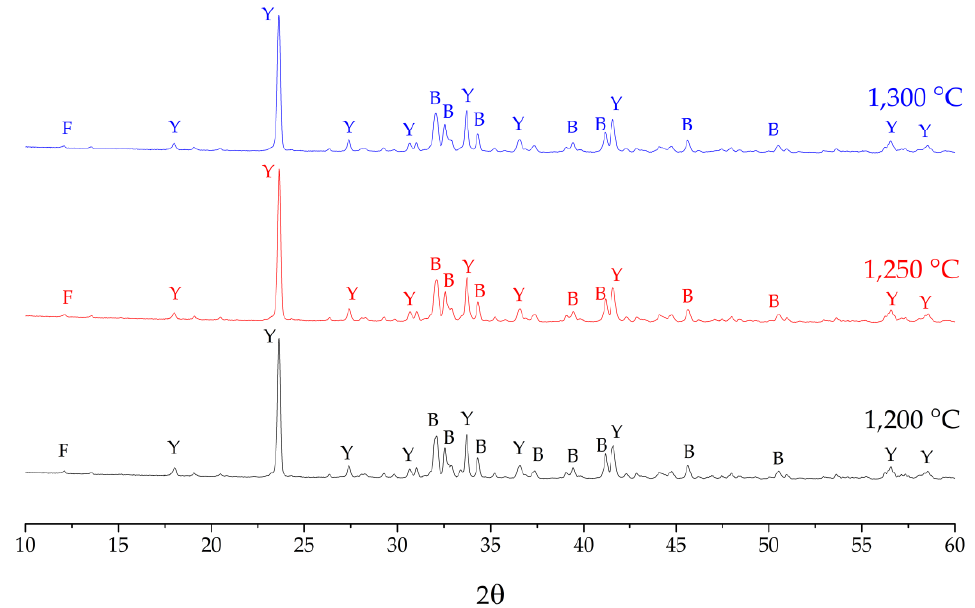
Figure 3. X-ray di ff raction patterns of CSA clinkers fired at di ff erence temperatures: Y = ye’elimite, Figure 3. X- ray diffraction patterns of CSA clinkers fired at difference temperatures: Y = ye’elimite, B B = belite, F = brownmillerite. = belite, F = brownmillerite. Table 3. Target phase composition of CSA clinker phase and CSA clinker phase composition fired at various temperatures calculated by Rietveld refinement